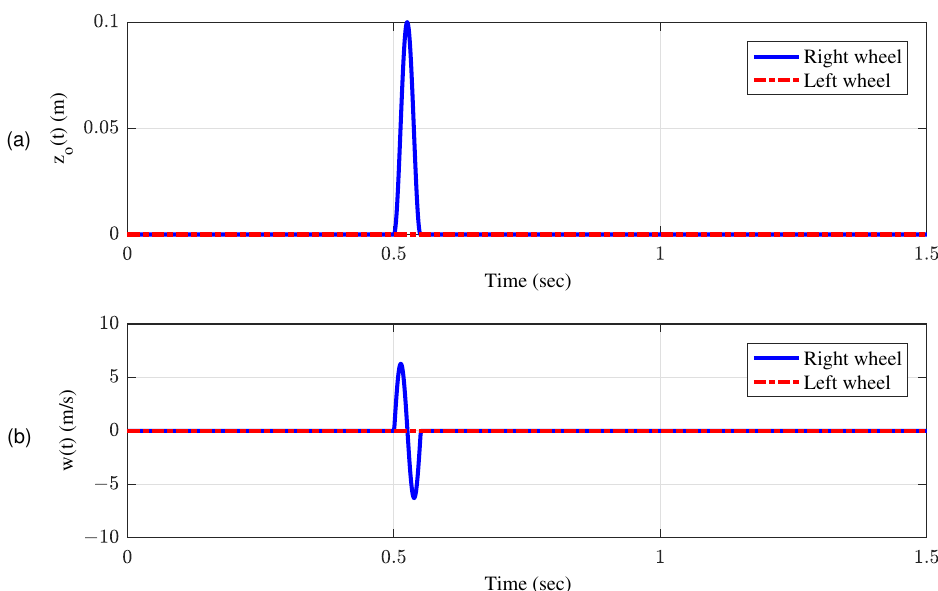
Figure 7. Road disturbance; ( a ) bump position input ( b ) bump velocity input.